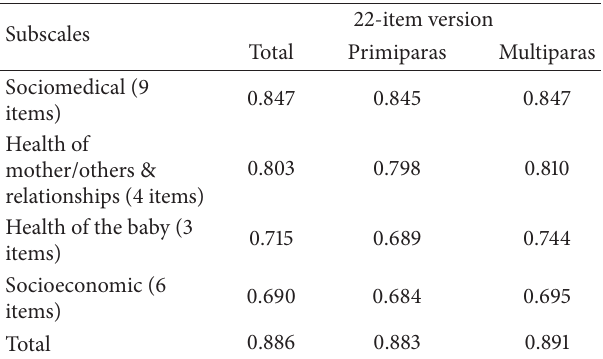
Table6:Cronbach’salphacoefficientsoftheFarsiCambridgeWorry